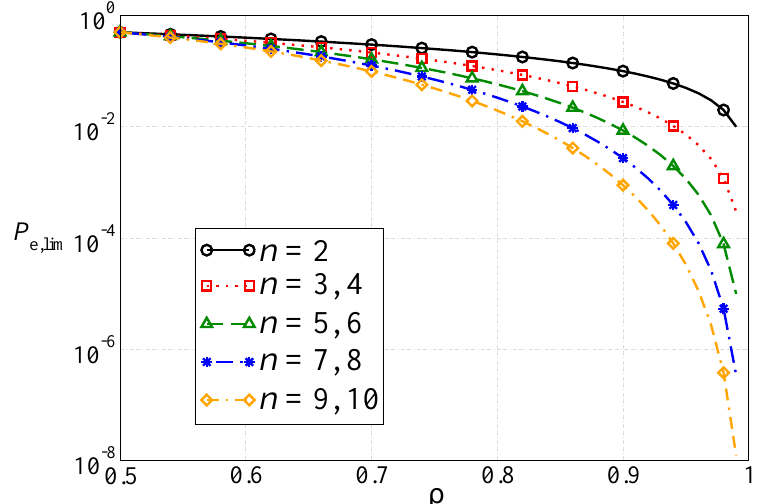
Figure 14. Limiting (for large SNR) probability of decision error as a function of the correlation coefficient, for the CEO scenario. Different values for the number of sensors n are